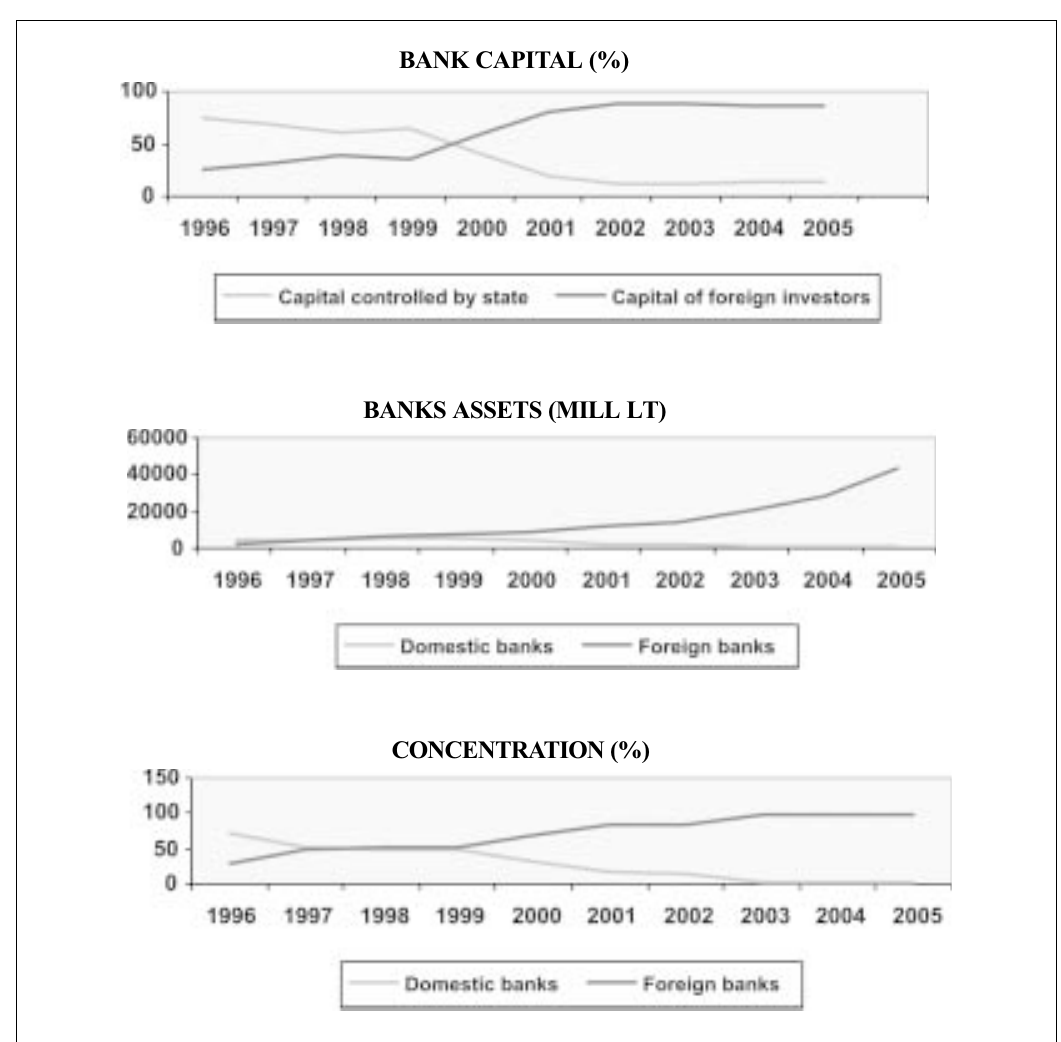
Fig 4 . Characteristic of market sector transformation in Lithuanian banking sector. Source of initial data: Lithuanian